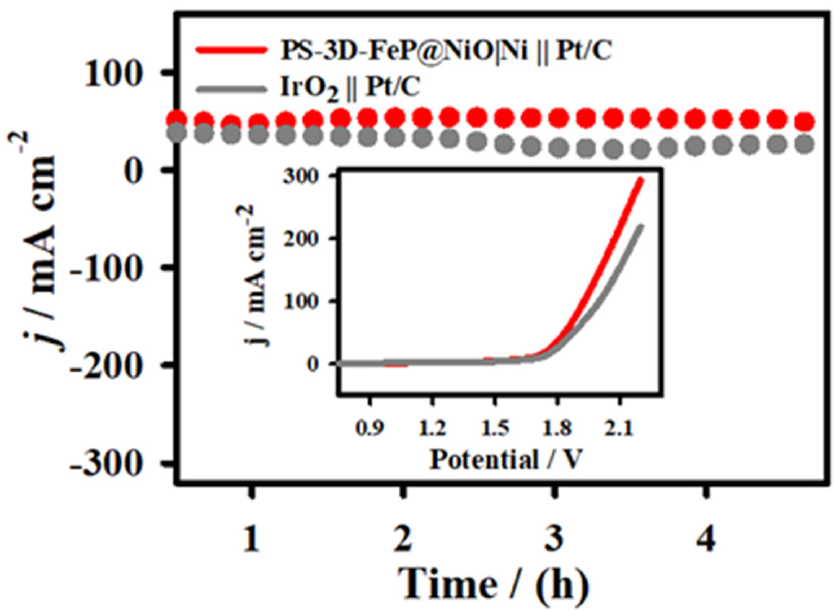
Figure 10. LSV curves of the PS ‐ 3D ‐ FeP@NiO|Ni||Pt/C (red curve) and state ‐ of ‐ the ‐ art IrO 2 |Ni||Pt/C (grey curve) couple for overall water splitting recorded in 1.0 M KOH at a scan rate of 20 mV s − 1